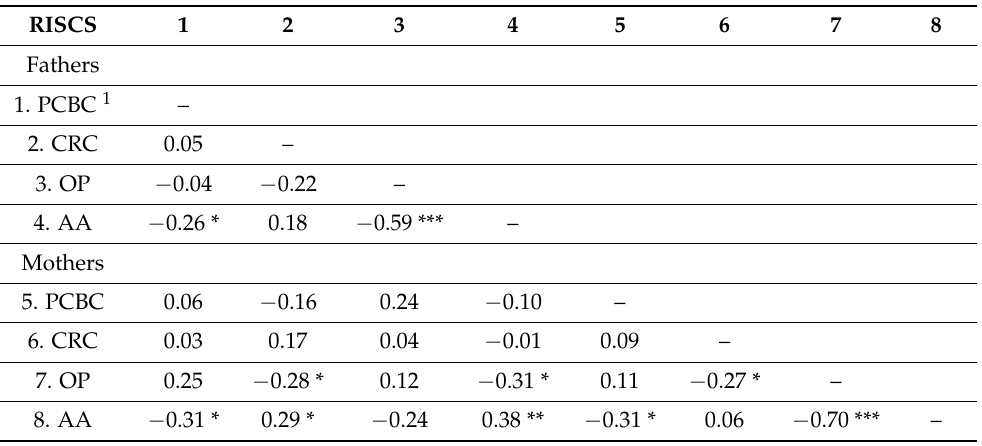
Table 2. Intercorrelations among RISCS